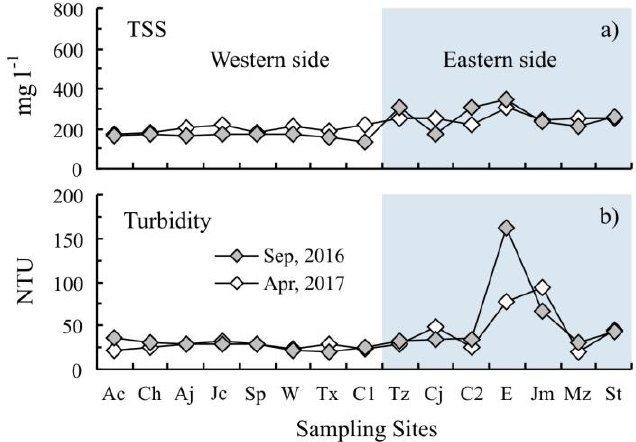
Figure 5. Ground-based data taken in this study. ( a ) Total suspended solids (TSS) and, ( b ) turbidity quantifications (locations shown in Figure 1).